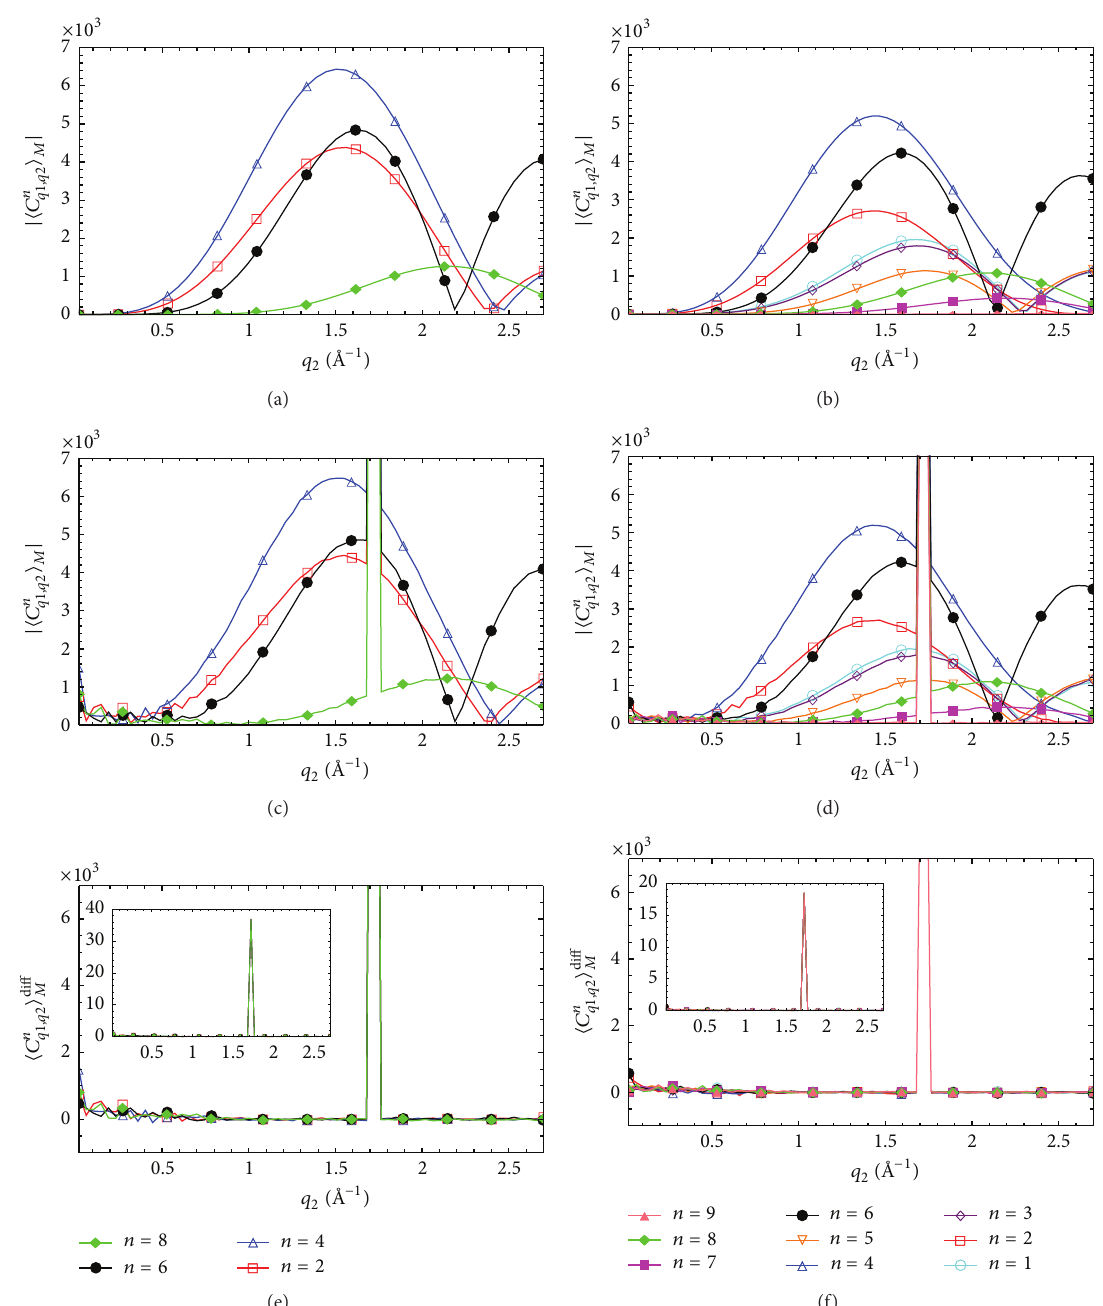
−1 ⟩ Figure 7: Fourier spectra ⟨𝐶 𝑛 𝑞 calculated as a function of 𝑞 2 ( 𝑞 1 = 1.71 ˚A ) for 1 ≤ 𝑛 ≤ 9 , for a flat (a), (c), (e) and curved (b), (d), (f) 𝑀 1 ,𝑞 2 ⟩ | calculated in dilute limit approximation of scattering (see (13)) from 𝑁 = 10 clusters, averaged Ewald sphere. (a), (b) Amplitudes |⟨𝐶 𝑛 𝑞 𝑀 1 ,𝑞 2 ⟩ | calculated for the case of coherent scattering (see (12)) from a cubic sample over 𝑀 = 10 4 diffraction patterns. (c), (d) Amplitudes |⟨𝐶 𝑛 𝑞 𝑀 1 ,𝑞 2 of 800 nm in size consisting of 𝑁 = 400 clusters, averaged over 𝑀 = 10 6 diffraction patterns. (e), (f) Difference spectra ⟨𝐶 𝑛 𝑞 difference (e) between the spectra in (c) and (a), and (f) between (d) and (b). The insets in (e) and (f) show full size of the peaks attributed to the inter-particle